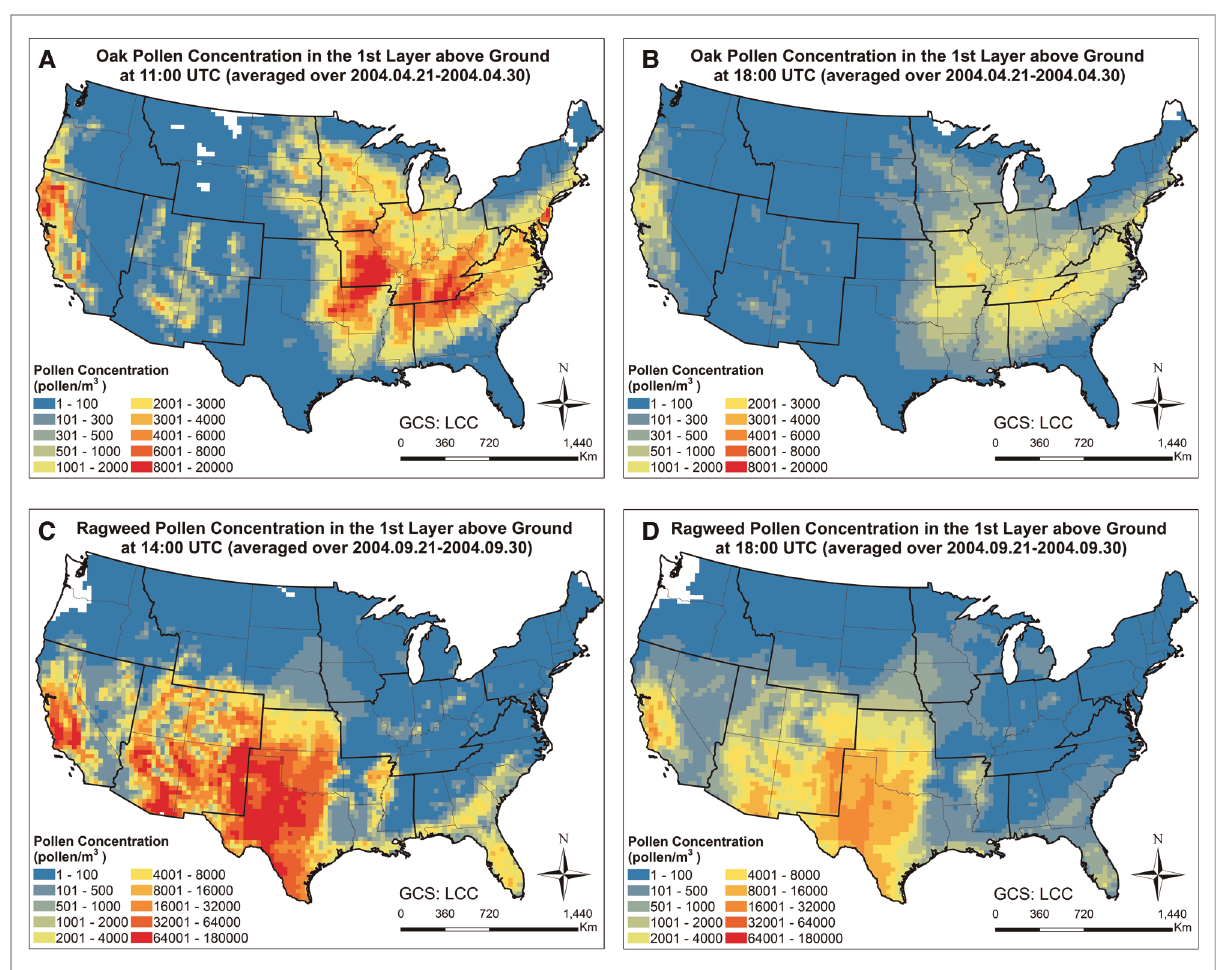
FIGURE 3 Time slices of spatiotemporal concentration pro fi les of ( A ) oak pollen at 11:00 UTC (averaged over Apr 21 – Apr 30, 2004); ( B ) oak pollen at 18:00 UTC (averaged over Apr 21 – Apr 30, 2004); ( C ) ragweed pollen at 14:00 UTC (averaged over Sept 21 – Sept 30, 2004); ( D ) ragweed pollen at 18:00 UTC (averaged over Sept 21 – Sept 30, 2004), calculated using the CMAQ-Pollen